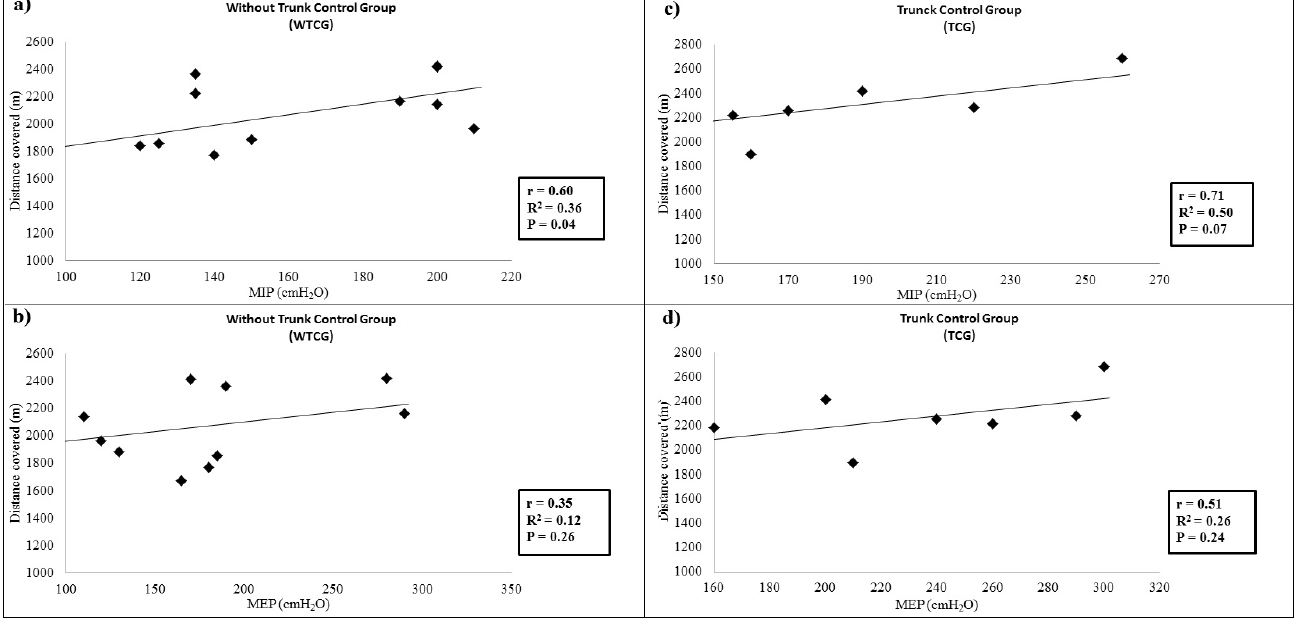
Figure 3. Correlations between the distances covered in the aerobic performance test and the maximum inspiratory pressure (MIP) and maximum expiratory pressure